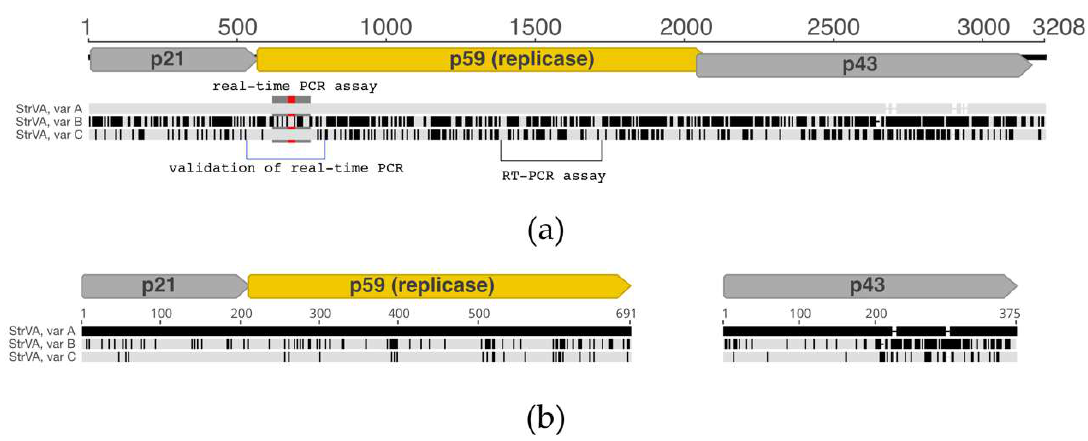
Table 2. Percentages of conserved nucleotide and amino acid (bold in parentheses) identities of StrVA’s ORFs and putative protein between viral variants coinfecting the 1/2017 strawberry plant. Virus